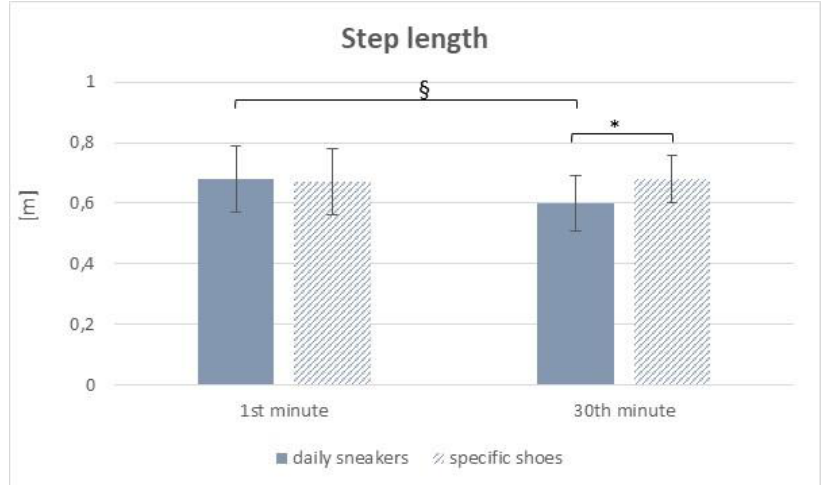
Figure 4. Mean and standard deviation of step length during the outdoor 30-min gait test for the deconditioned group during the early (1st minute) and last (30th minute) segment of the test during the two sessions (daily sneakers vs. specific shoes). * = p < 0.05, statistically significant in the post hoc comparison daily sneakers vs. specific shoes; § = p < 0.05, statistically significant in the post hoc comparison 1st minute vs. 30th